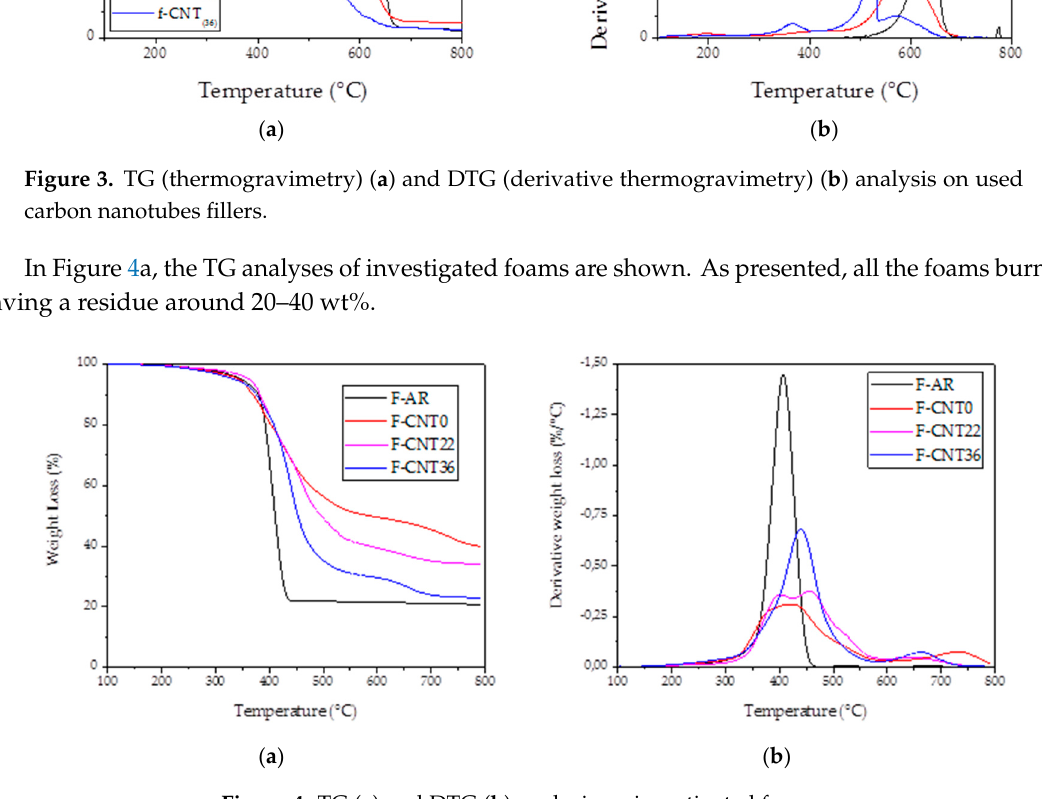
Figure 4. TG ( a ) and DTG ( b ) analysis on investigated foams.